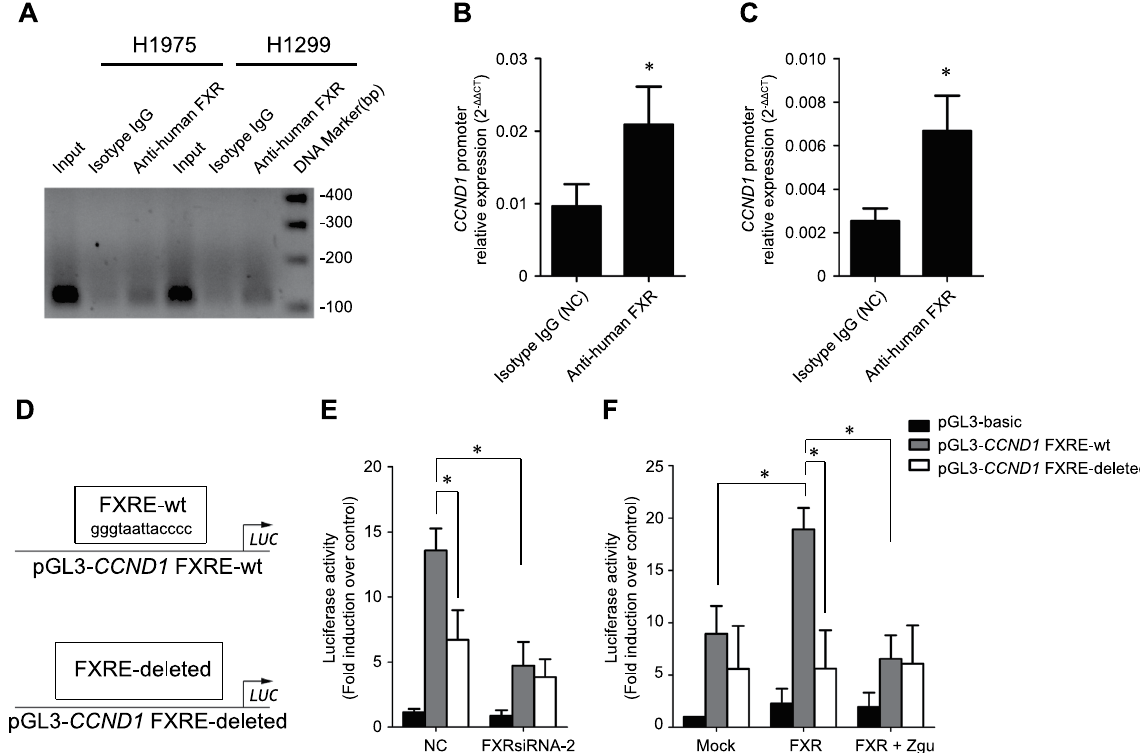
Figure 5. FXR is recruited to the cyclin D1 promoter and promotes its transcription. A ChIP assay was performed in H1975 and H1299 cells with anti-human FXR mouse monoclonal antibody and primer sets described in the “Materials and methods” section. The isotype IgG was used as a negative control (NC), and the input chromatin sample was used as a positive control. ( A ) Representative PCR amplification products are shown. Enrichment of FXR protein in the putative motif of CCND1 promoter in H1975 ( B ) and H1299 ( C ) cells was determined relative to input samples, respectively. ( D ) Schematic representation of a wild-type CCND1 reporter plasmid (pGL3- CCND1 FXRE-wt) and an FXRE-deleted CCND1 reporter plasmid (pGL3- CCND1 FXRE-deleted). ( E ) H1975 cells were transfected with NCsiRNA or FXRsiRNA-2; ( F ) HCC4006 stable cell lines were treated with or without Z-guggulsterone (Z-gu, 40 μ M). One day later, all cells were transfected with the indicated reporter plasmids and then collected for measurements of the luciferase activities at 24 h post- transfection. The data were presented as the mean ± SD of at least three independent experiments. * p <